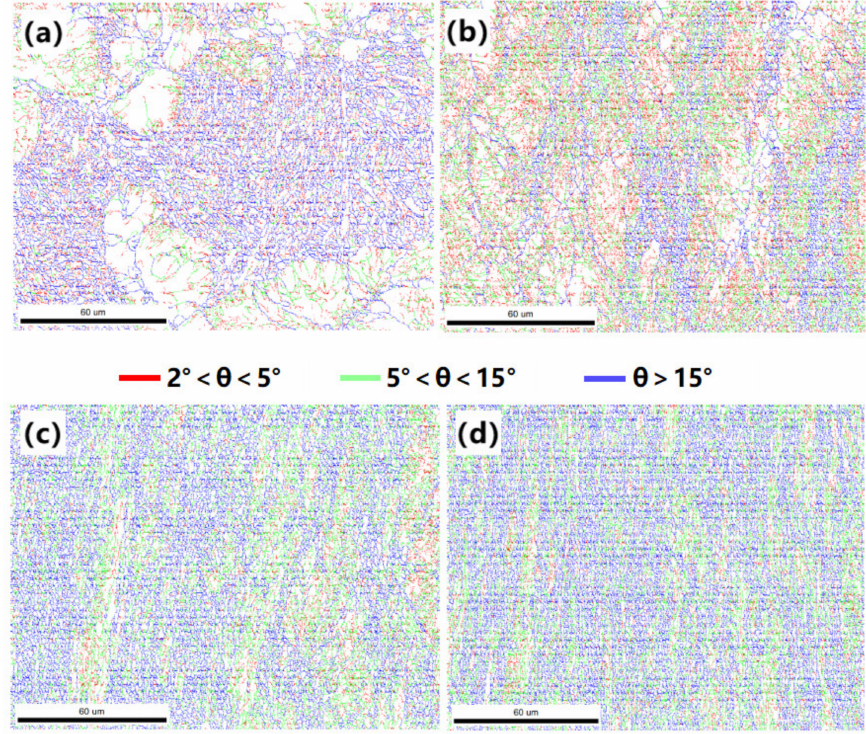
Figure 10. Grain boundary maps at different deformation strains: ( a ) 20%, ( b ) 40%, ( c ) 60%, ( d ) 75%.